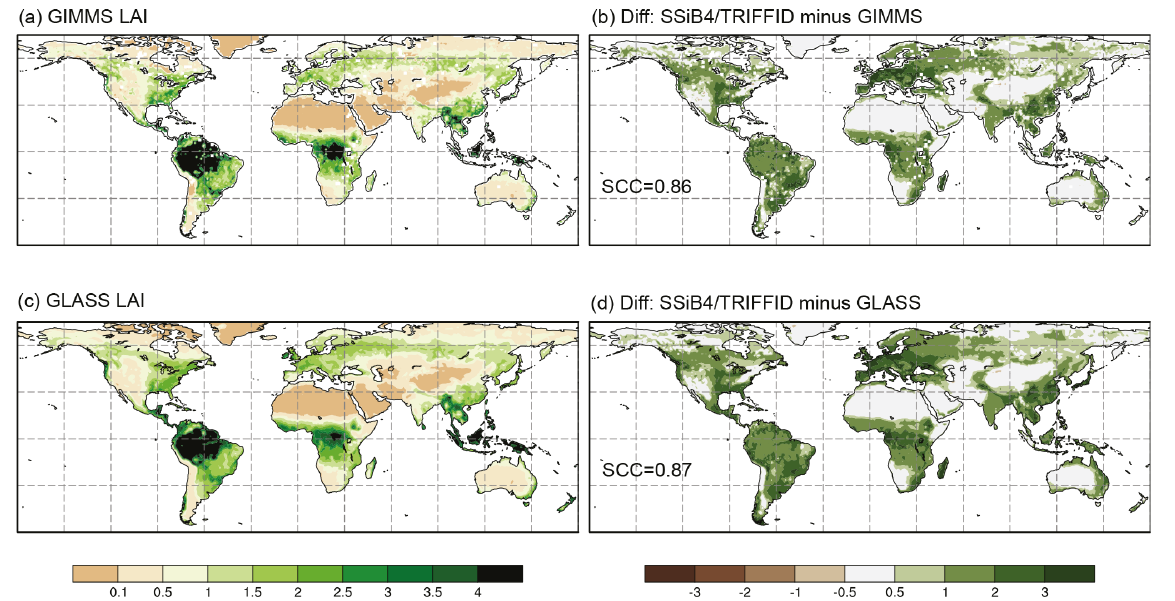
Figure 4. The 1982–2007 average leaf area index comparison for (a) GIMMS LAI, (c) GLASS LAI, and difference between SSiB4/TRIFFID and (b) GIMMS and (d) GLASS. SCC indicates the spatial correlation coefficient between model simulation and satellite-derived datasets.